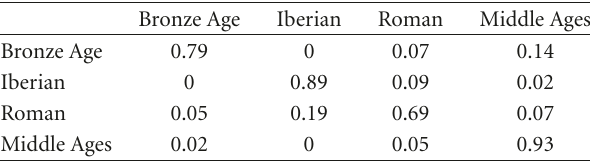
Table 3: Confusion matrix (percentages) by NP-ICA with 1 PSS